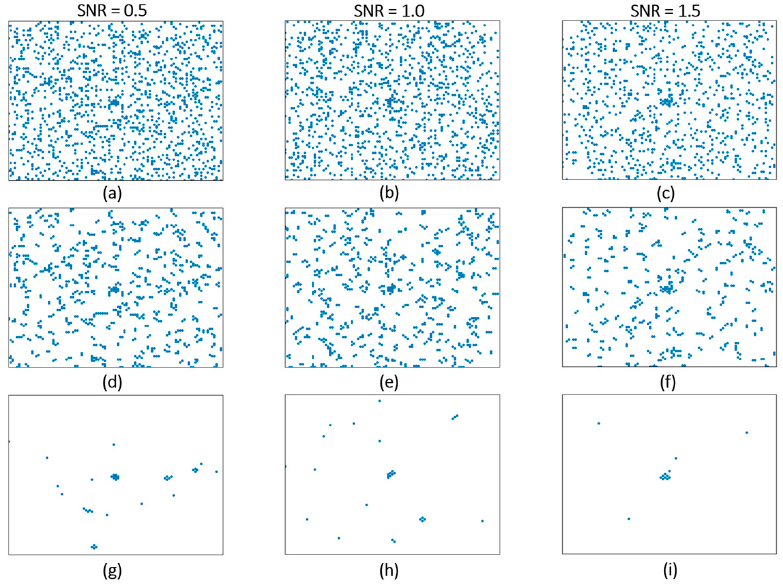
11 of 28 Figure 7. Outliers: ( a – e ) show points with connected domains; ( f ) shows outliers. In the experiment, in order to obtain be tt er results, we adjusted the judgment crite- rion and experimented on the cases of 4-neighborhoods and 8-neighborhoods. We re- moved the data with di ff erent SNRs for 4-neighborhood outliers and 8-neighborhood out- liers once, and the results are shown in Figures 8 and 9. We found that selecting no other